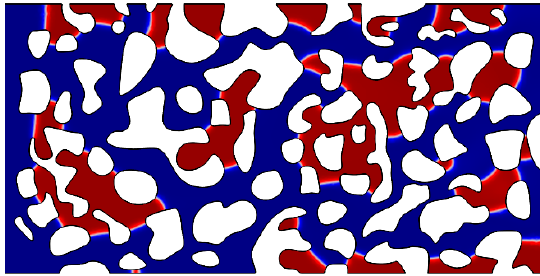
Figure 3. Residual oil distribution in the oil-wet porous medium when the water cut is 98%. The white regions are rock matrix, and the red and blue regions represent oil and water, respectively. (1) isolated oil droplet; (2) oil film; (3) residual oil in dead ends; (4) residual oil in pore throats; and (5) cluster residual oil.